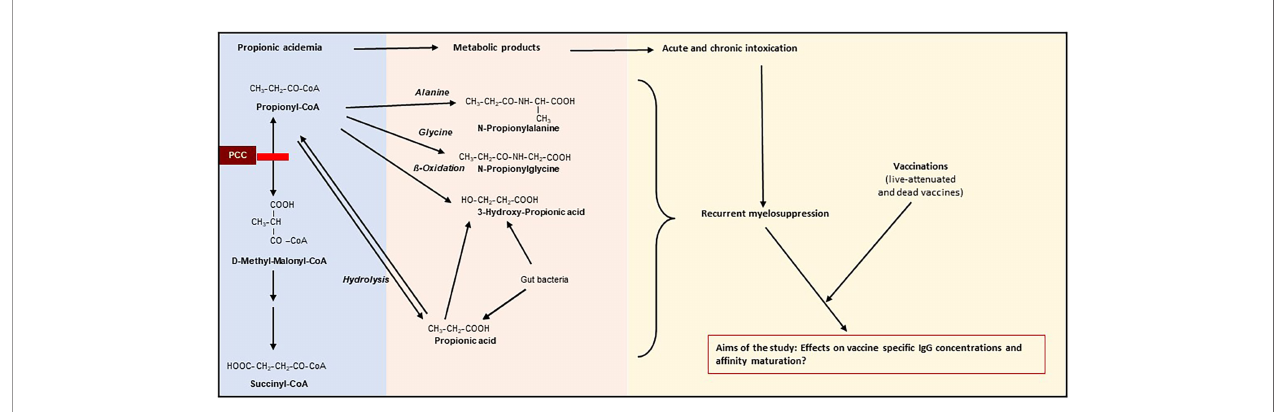
FIGURE 1 | Schematic description of pathophysiology of propionic acidemia (PA) and the aims of our study [partly adapted from (1, 15)]. PCC, propionyl-CoA carboxylase; Grey line indicates blockage of PCC. Propionic acidemia is caused by an autosomal recessively inherited de fi ciency of the mitochondrial enzyme propionyl-CoA carboxylase, resulting in the accumulation of propionic acid and related metabolic products (e.g., propionyl CoA, propionylcarnitine, 3-hydroxy- propionic acid, propionic acid). Abnormal amounts of metabolic products result in an intoxication type disorder associated with either acute or chronic symptoms (neurological symptoms (associated with progressive encephalopathy of varying severity), gastrointestinal symptoms (failure to thrive, anorexia), hematological abnormalities (neutropenia, pancytopenia), and heart failure [prolonged QTc interval, cardiomyopathy)]. The in fl uence of recurrent immunosuppressive episodes during early infancy on immune outcome to vaccination remains